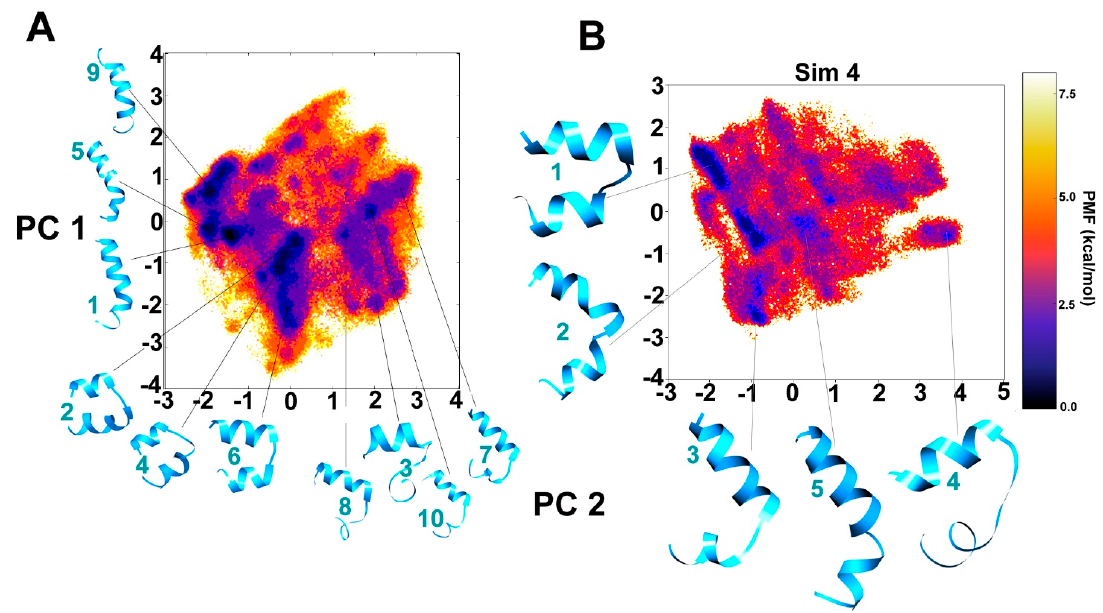
Figure 2. Reweighted potential of mean force (PMF) free energy landscapes of the first two principal components (PCs) calculated from dihedral angles, phi-psi, for better clustering based on internal motions. The deepest blue regions indicate energy minimum. The representative structures of each cluster are provided for ( A ) combined 3 simulations, ( B ) the 4th simulation. The cluster numbers are given in cyan.